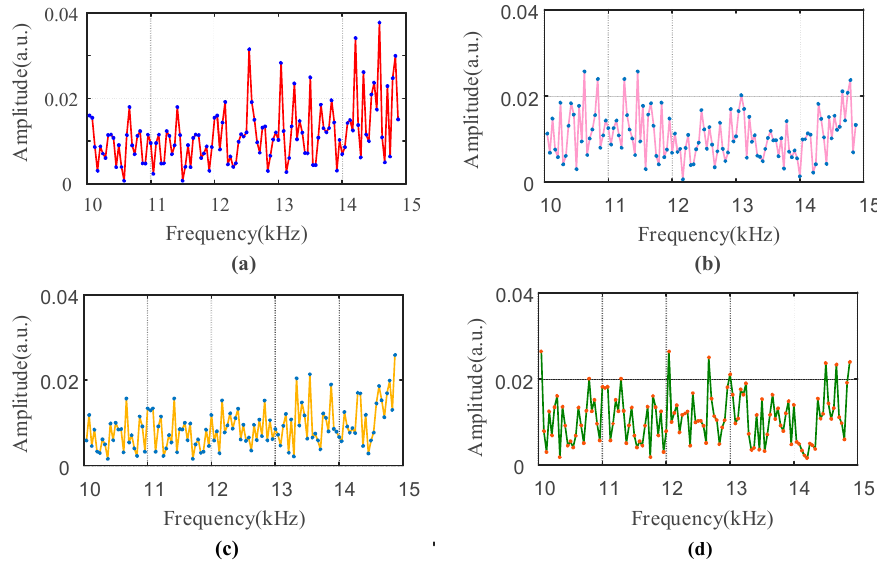
Figure 4. The distribution of the frequency between 10 kHz and 15 kHz after using the recursive FFT for different moments, where ( a ) corresponds to the moments of drilling the cortical bone; ( b ) is related to the cancellous bone; ( c ) is the transition region from cortical bone to cancellous bone and ( d ) is the transition region from cancellous bone to the inner cortical bone. In addition, the y -label is energy intensity distribution at various frequency values.